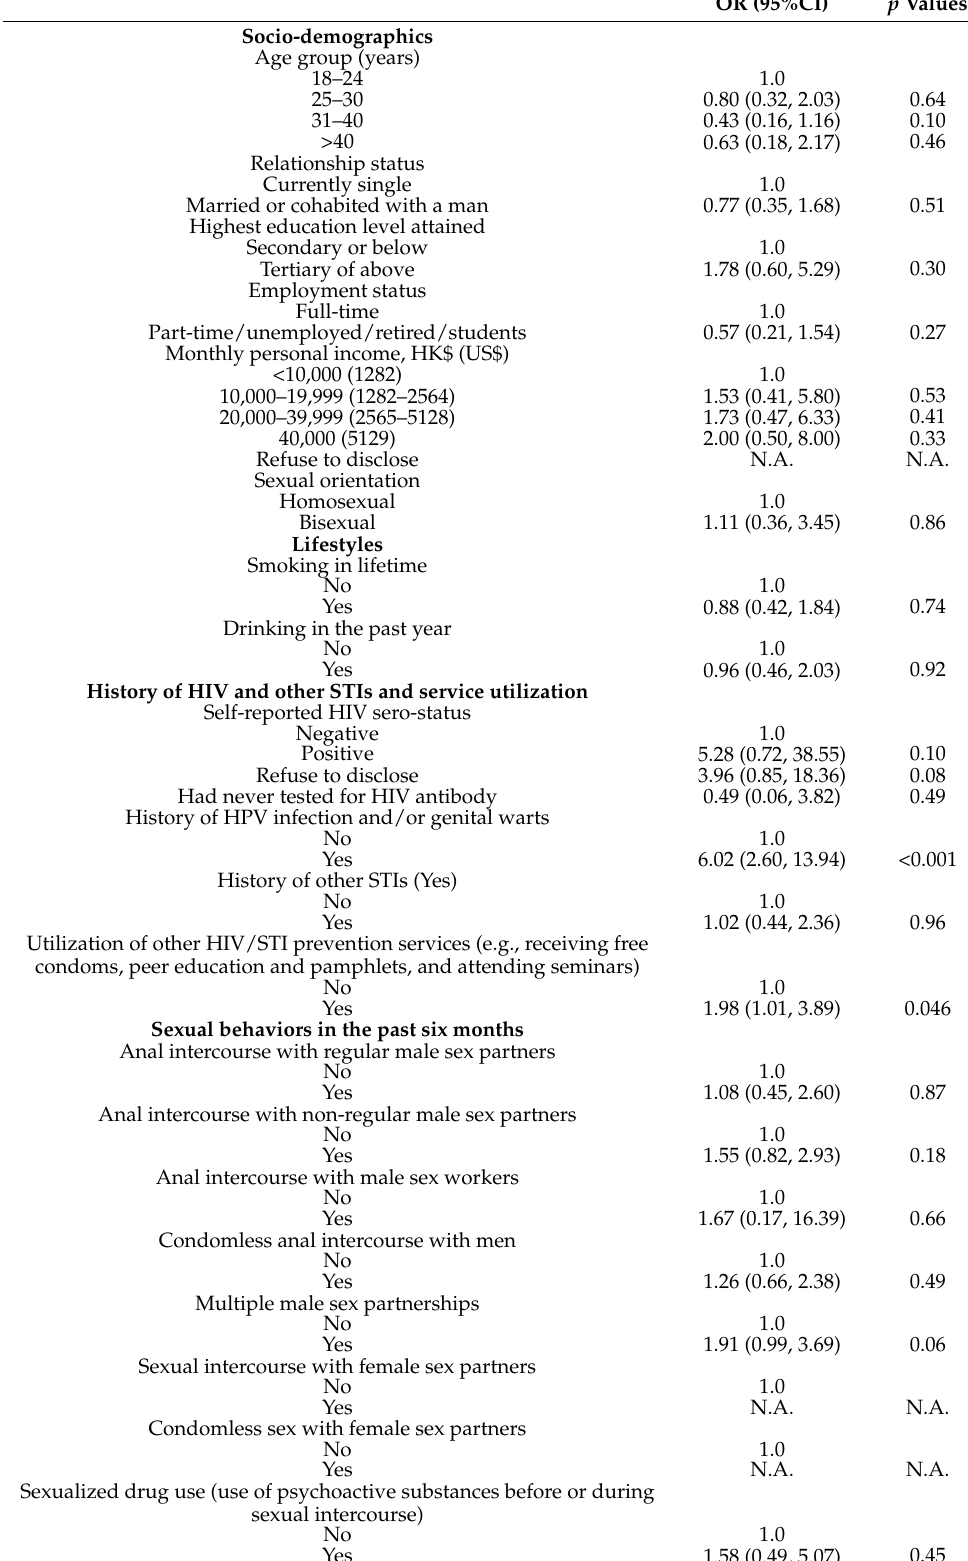
Table 2. Baseline background characteristics predicting human papillomavirus vaccination uptake (among participants who completed Month 12 follow-up, n =